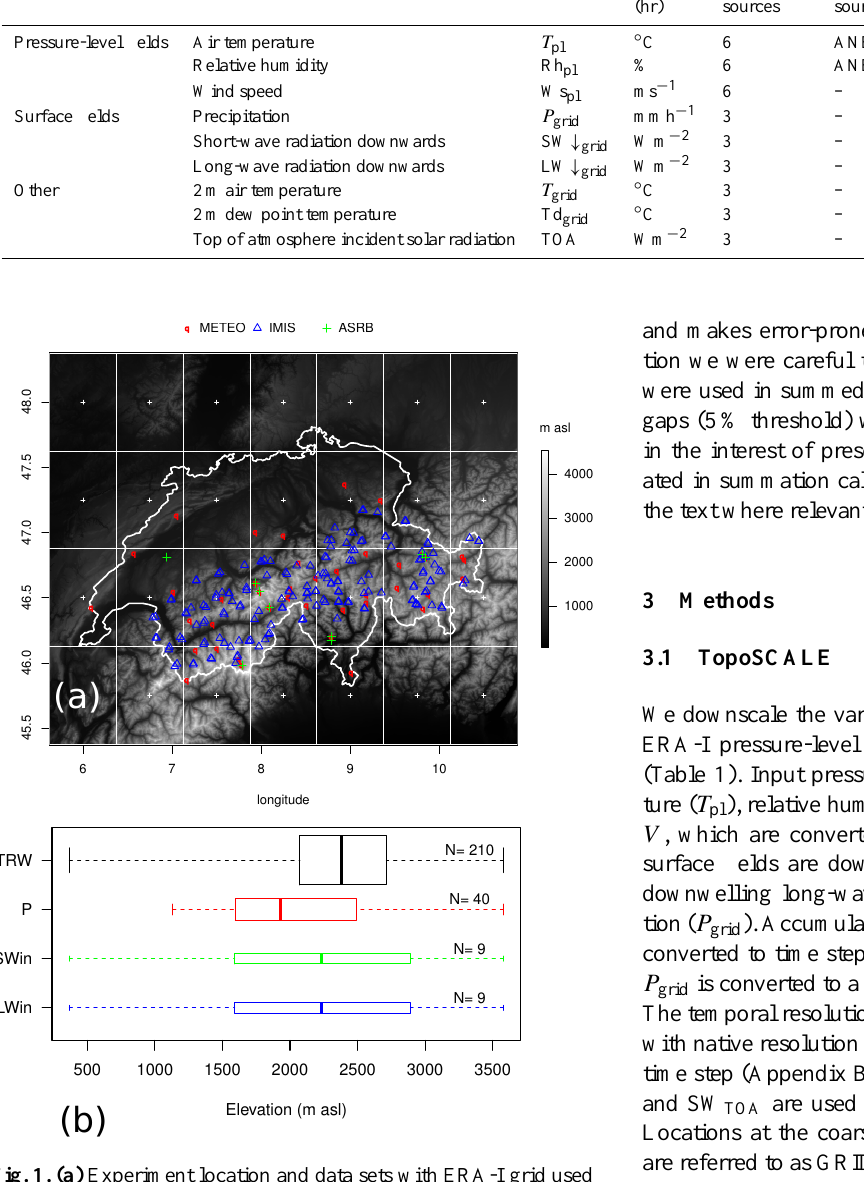
Fig. 1. (a) Experiment location and data sets with ERA-I grid used in this study. (b) Elevation distributions of stations by variable: T , Rh, Ws (TRW, 210), P (40), SW ↓ (9), LW ↓ (9). The boxes are drawn with widths proportional to the square-root of the number of stations in the